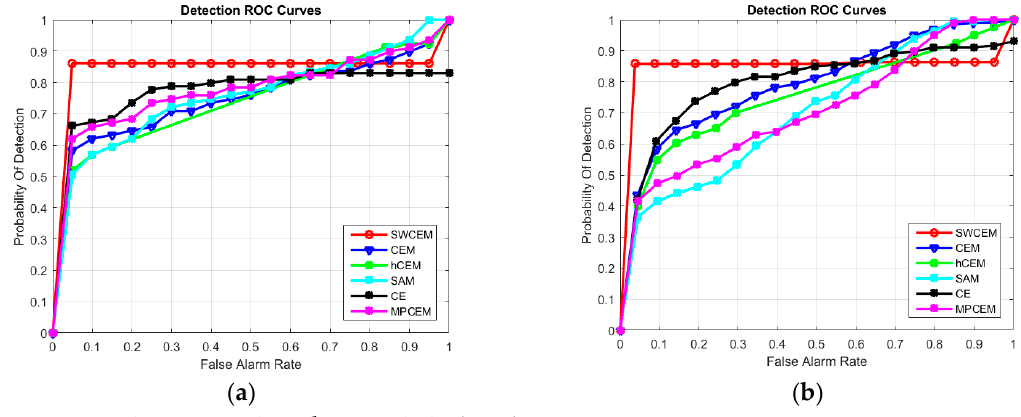
Figure 12. Receiver operating characteristic (ROC) curves on the two scenes: ( a ) ROC curves of different algorithms on the first scene; and ( b ) ROC curves of different algorithms on the second scene. Table 1. The area surrounded by ROC curves of different algorithms on the first scene.